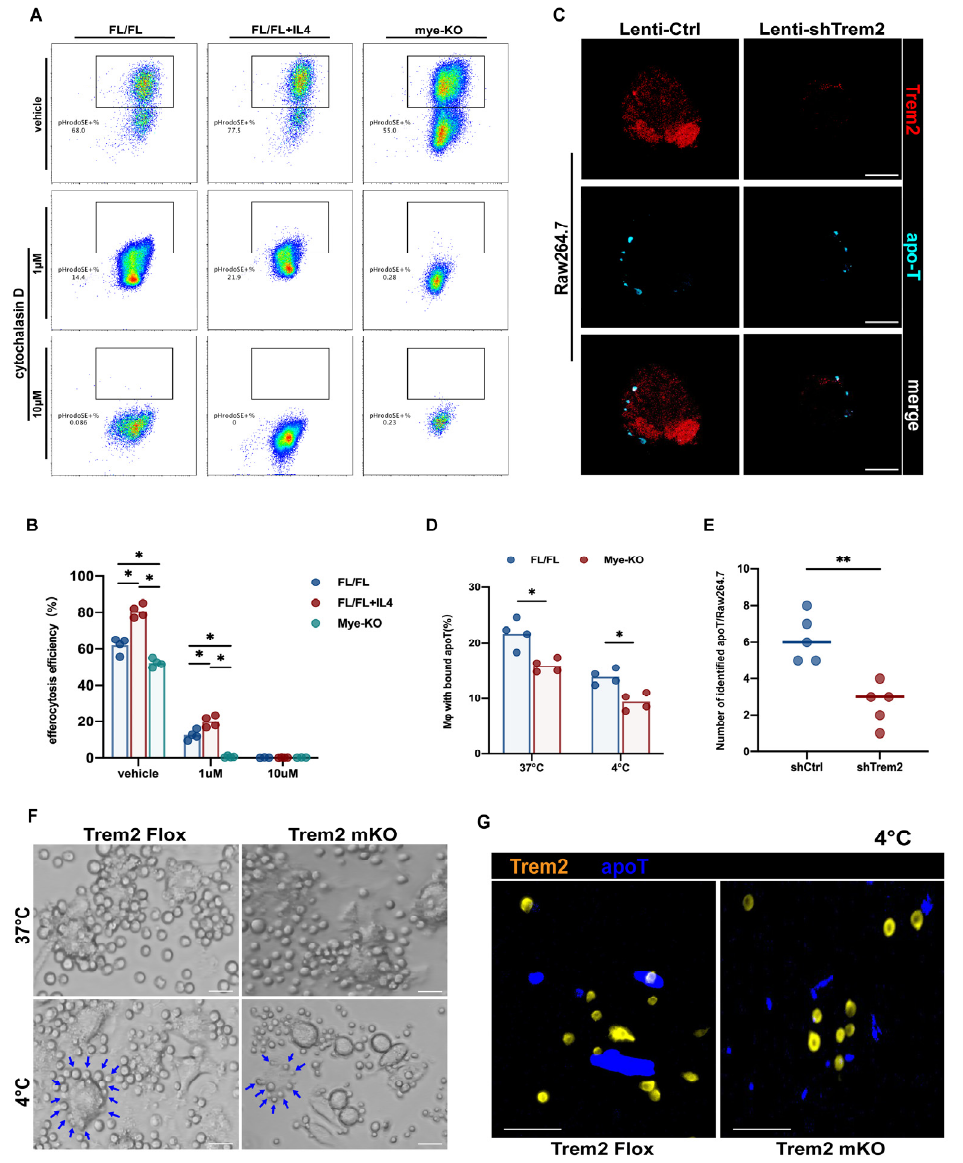
Figure 6. Trem2 is involved in regulating the recognition and internalization of efferocytosis by monocyte macrophages. ( A ) BMDMs under different stimulation conditions, such as Trem2 FL / FL , Trem2 FL / FL +IL4, and Trem2 mKO , were incubated with 1 µ m or 10 µ m cytochalasin D when running efferocytosis, and then ( B ) the efficiency of efferocytosis was detected ( n = 4, * p < 0.05); ( C , E ) the number of apoptotic thymocytes combining with Raw264.7 per Lenti-shCtr1 or Lenti-shTrem2 at 37 ◦ C or 4 ◦ C ( n = 4, ** p < 0.01, scale bars = 100 µ m); ( D , F , G ) Number of BMDMs bound apoptotic thymocytes per Trem2 FL/FL or Trem2 mKO at 37 ◦ C or 4 ◦ C. The blue arrows represent the apoptotic thymocytes attached to BMDMs ( n = 5, * p < 0.05, scale bars = 10 µ